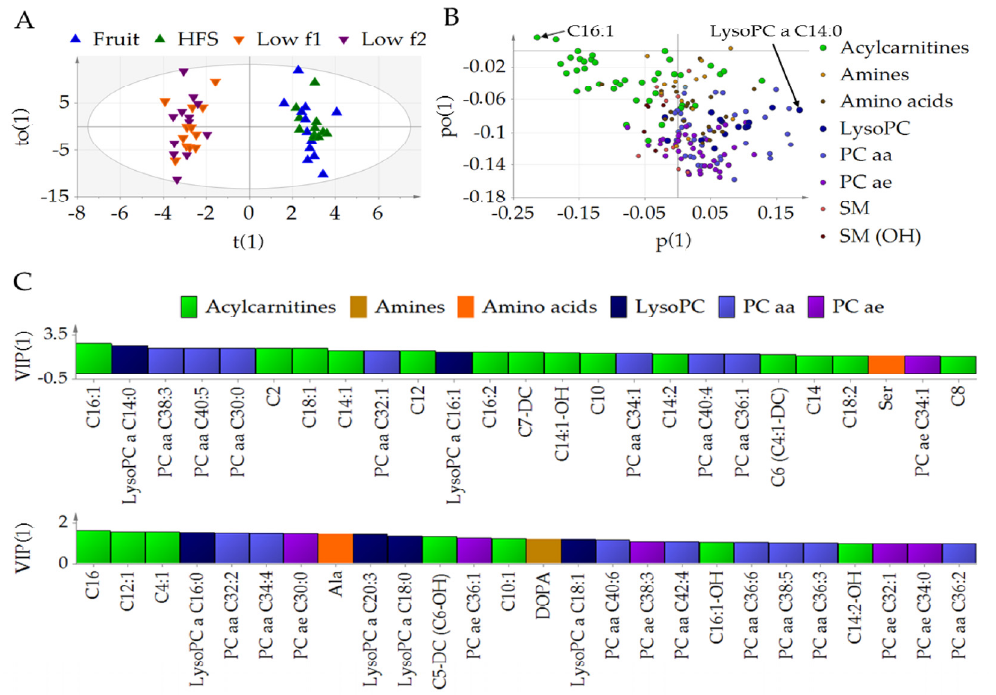
Figure 2. Orthogonal partial least squared-discriminant (OPLS-DA) analysis. Class separation is shown by ( A ) scatter plot, ( B ) loading plot, ( C ) Variable of Importance for Prediction (VIP). t(1), score vector of predictive component 1; to(1), score vector of orthogonal component 1; po(1), loading vector of orthogonal component 1; p(1), loading vector of component 1. Abbreviations: HFS, high fructose